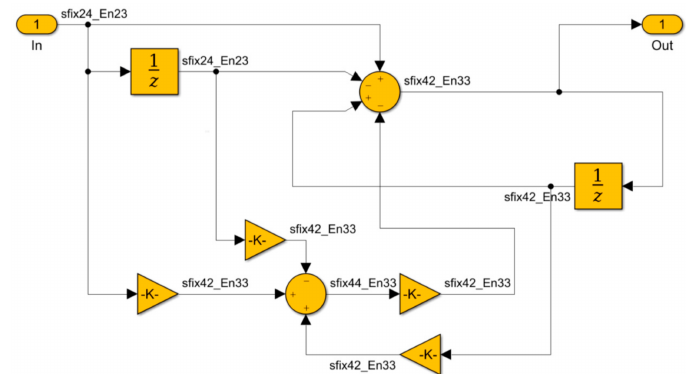
Figure 6. Fixed-point filter Simulink diagram.